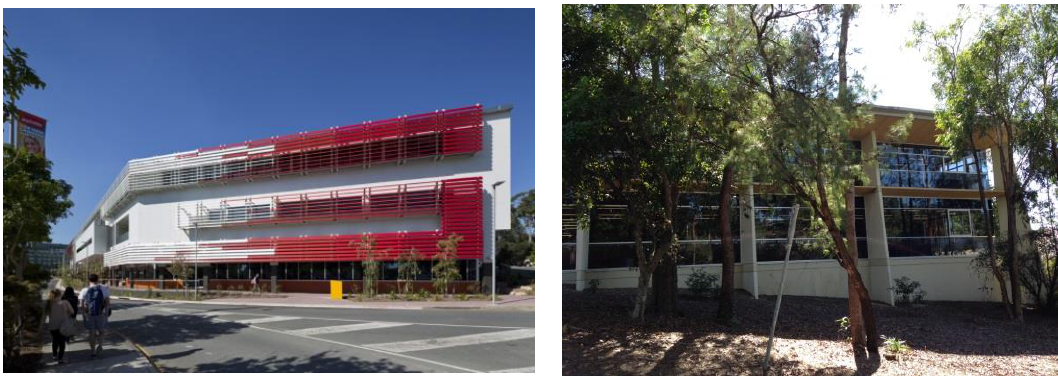
Figure 1. Griffith University Gold Coast Library and its shading strategies: louvers for west facing facades, horizontal and vertical projections for north, south and east facing facades, and trees around the building.